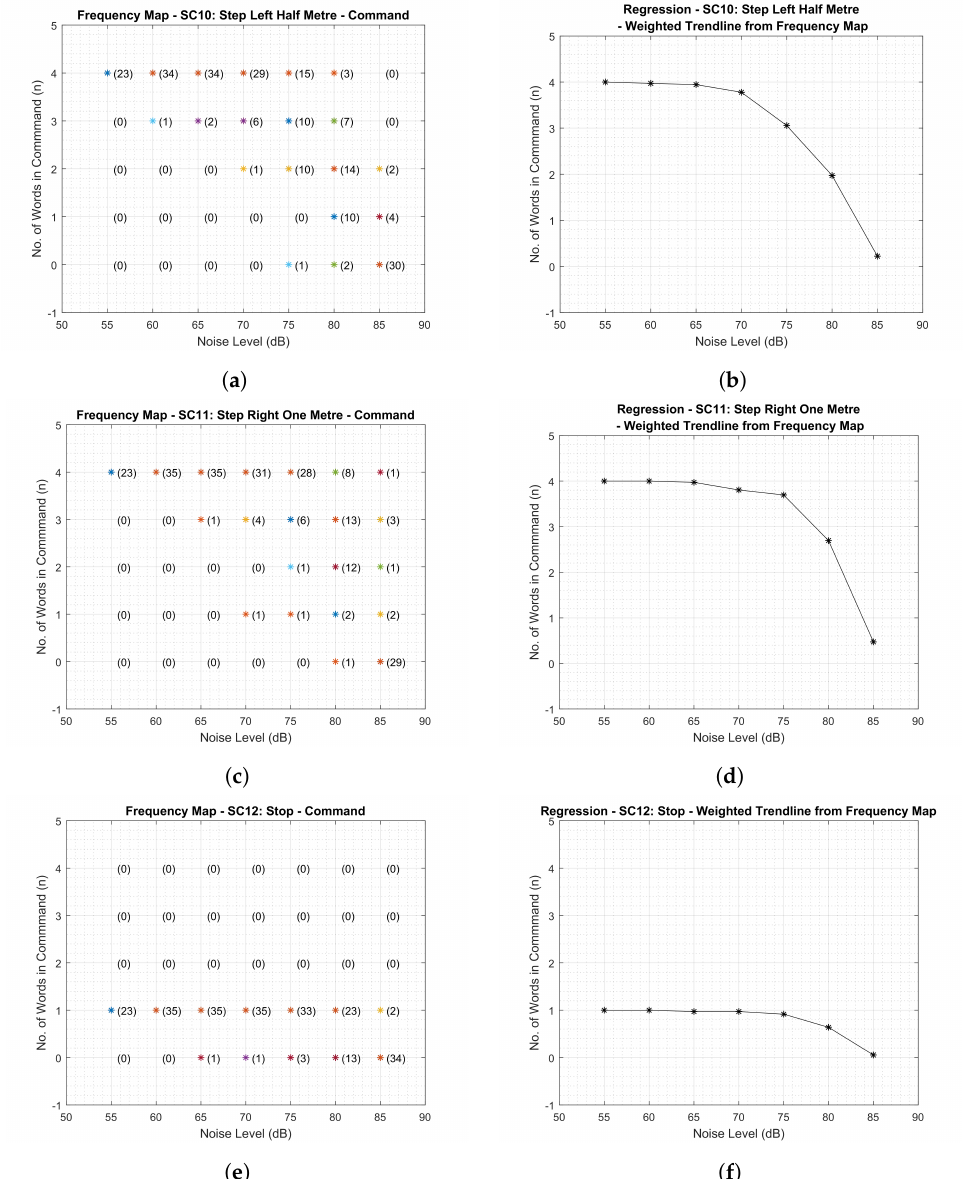
Figure 6. Frequency map and trendlines III. ( a ) SC10 frequency map, ( b ) SC10 trendline, ( c ) SC11 frequency map, ( d ) SC11 trendline, ( e ) SC12 frequency map, ( f ) SC12